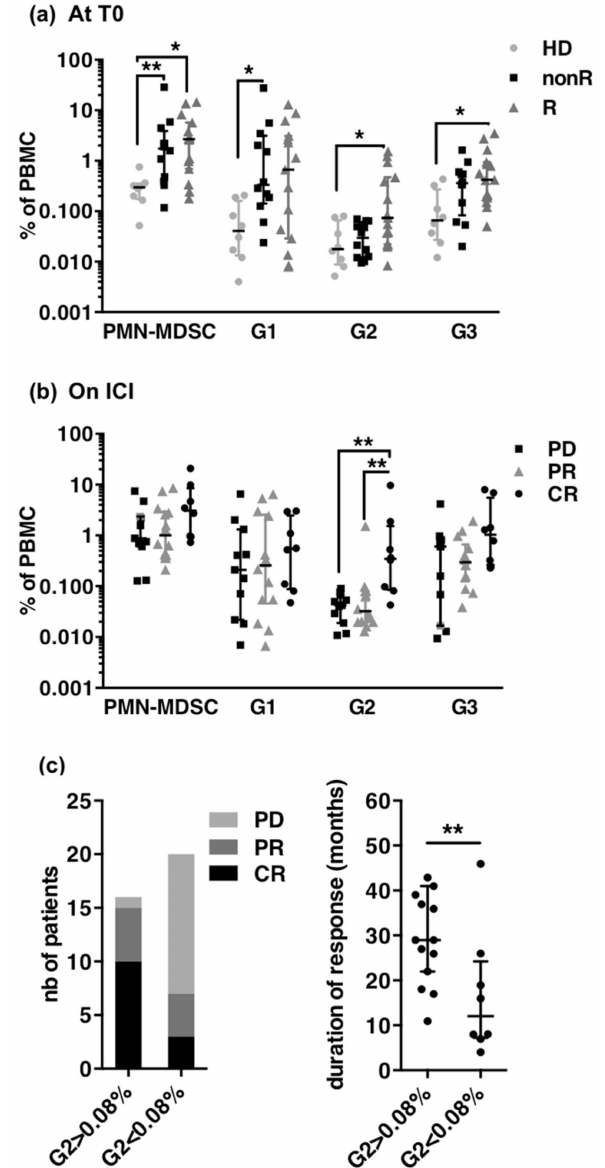
Figure 6. Frequencies of PMN-MDSC subsets in melanoma patients treated with ICI. ( a ) Frequencies of PMN-MDSCs, G1, G2 and G3 in PBMCs of HD (healthy donors, n = 8) and patients at treatment start according to best response achieved, non R (non responders, n = 12; 11 PD, 1 SD), R (responders, n = 15; 6 PR, 9 CR). Median and IQR. p -values of Dunn’s multiple comparison post Kruskall–Wallis test are indicated on top of pairs: p < 0.05 *; p < 0.01 **. ( b ) Frequencies of PMN-MDSCs, G1, G2 and G3 in patients according to the radiological response at the time of sampling (CR, n = 7; PR n = 11; PD n = 10; SD n = 1). Median and IQR, p -values of Dunn’s multiple comparison post Kruskall-Wallis test are indicated on top of pairs: p < 0.05 *; p < 0.01 **. ( c ) Radiological response (left) and mean duration of response (right) in patients according to G2 frequency above ( n = 16, including 10 CR and 5 PR) or below ( n = 20, including 3 CR and 4 PR responders) the threshold of 0.08%. p -values of Mann-Whitney U -tests are indicated on top of pairs: p < 0.01